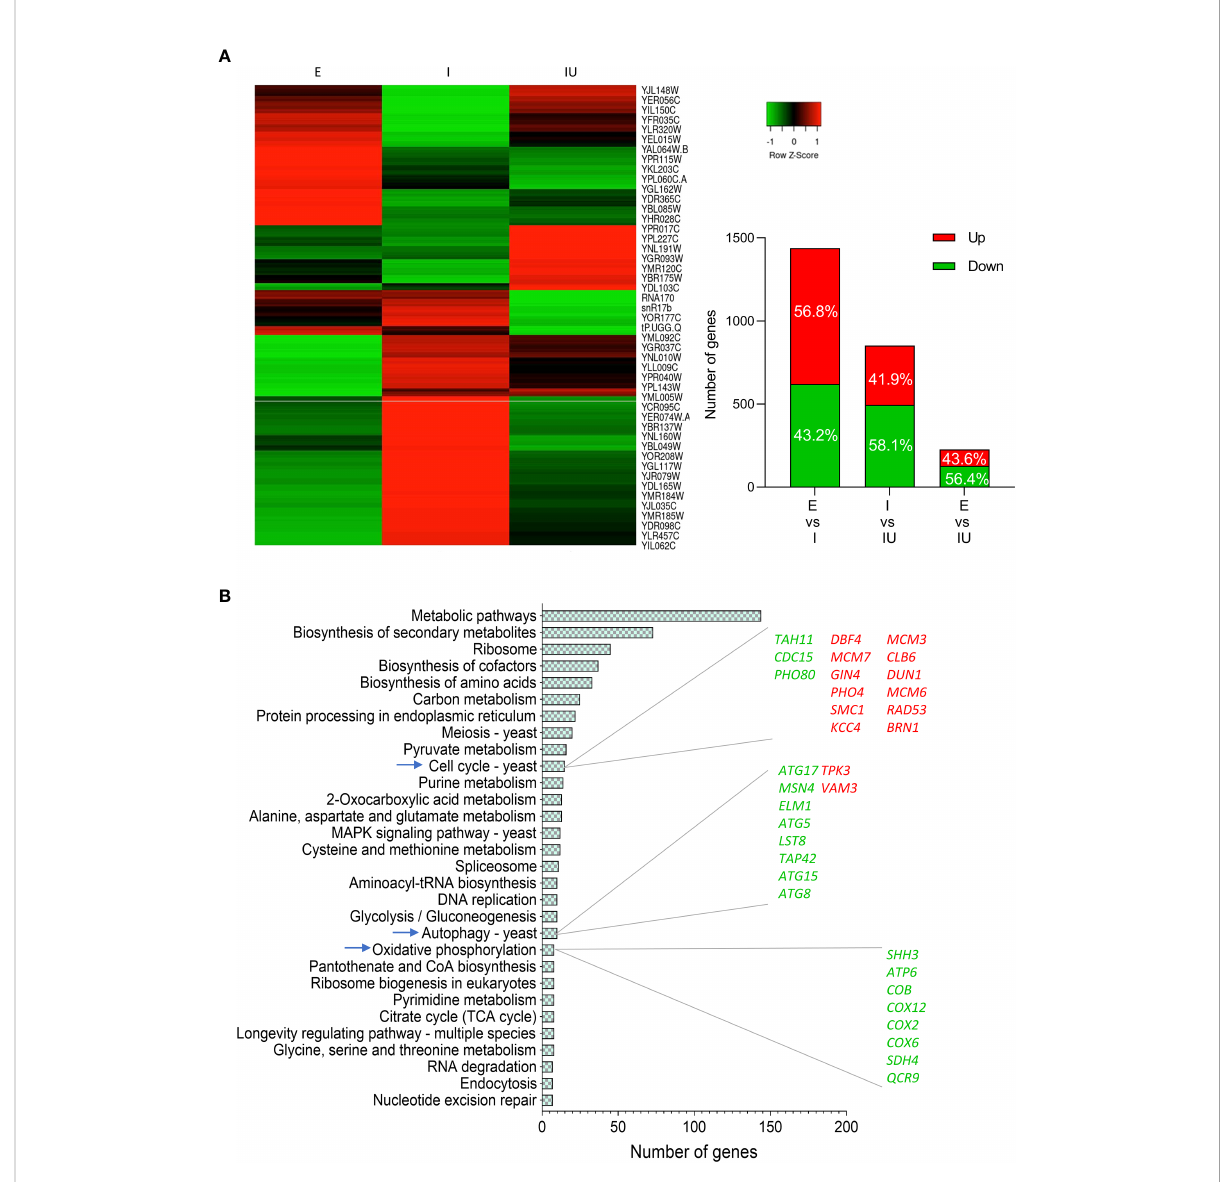
FIGURE 4 Urolithin B induces a massive transcriptomic change in IAPP-expressing cells (A) Heatmap of differently expressed genes of cells expressing ppIAPP with or without 50 µM urolithin B (UroB) and the control expressing the empty vector (left panel). Number of differently expressed genes and distribution in up and downregulation between each comparison (right panel). (B) Functional enrichment analysis obtained from GeneCodis of differently expressed genes between cells expressing ppIAPP with or without 50 µM UroB. The list of genes up and down regulated of the explored pathways is also depicted. E, cells containing the empty vector; I, cells expressing ppIAPP; IU, cells expressing ppIAPP incubated with